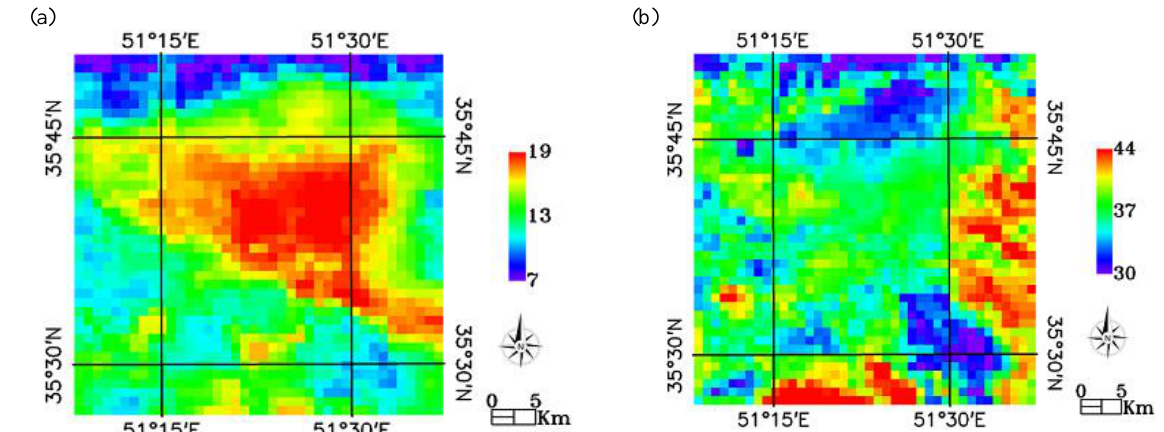
Figure 3, Land Surface Temperature derived from AVHRR satellite images at (a) 01:51, (b)